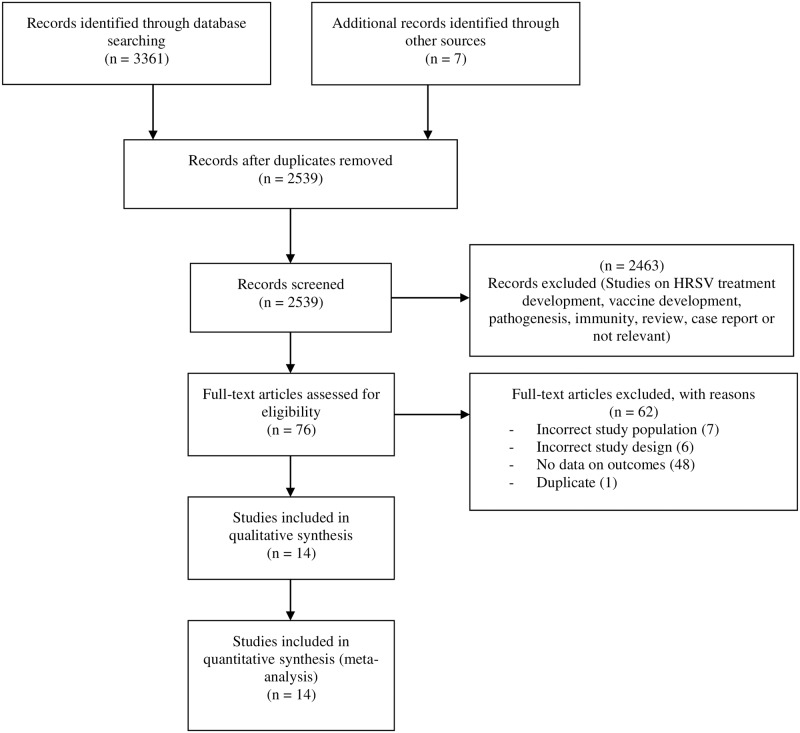
Flow chart for the systematic literature search.